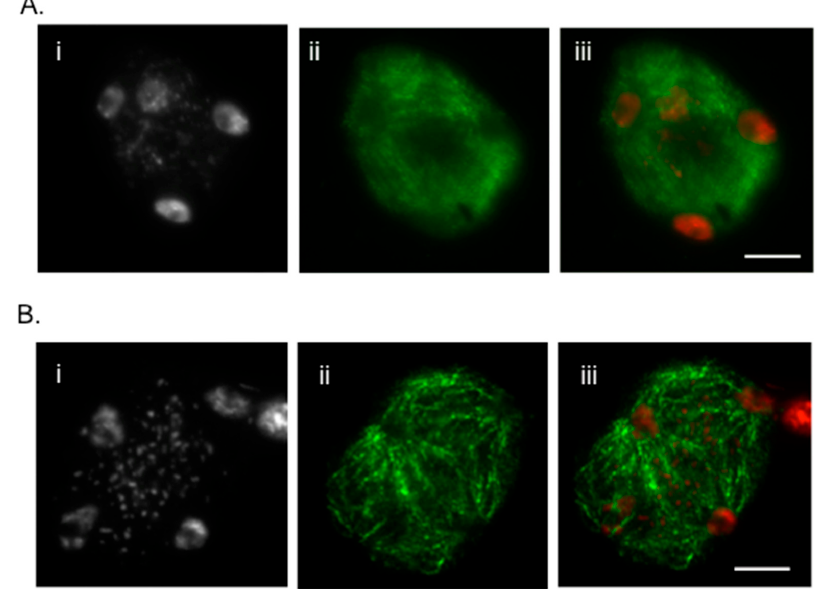
Figure 1. ( A ) Immunolocalization of beta tubulin in paraformaldehyde-fixed male meiocytes with enzymes. (i) 4’,6-diaminido-2-phenlyinidole (DAPI)-stained tetrad, (ii) beta tubulin stained tetrad and (iii) Merged. Chromosomes are counterstained with DAPI (left image of each panel); Bar = 10 μ m. ( B ) Immunolocalization of beta tubulin in paraformaldehyde-fixed male meiocytes without enzymes. (i) DAPI-stained Tetrad, (ii) beta tubulin stained tetrad and (iii) Merged. Chromosomes are counterstained with DAPI (left image of each panel); Bar = 10 μ m.